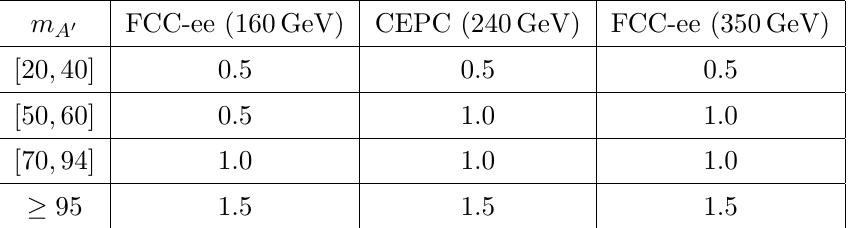
Table 2 . The dependence of (cid:1) m on m A 0 and the c.m. energy. FCC-ee (160 GeV) and FCC-ee (cid:22) + (cid:22) (cid:0) p (350 GeV) denote the FCC-ee at s = 160 GeV and 350 GeV, respectively. CEPC (240 GeV) p denotes the CEPC at s = 240 GeV. All the numbers in the table are in units of GeV.